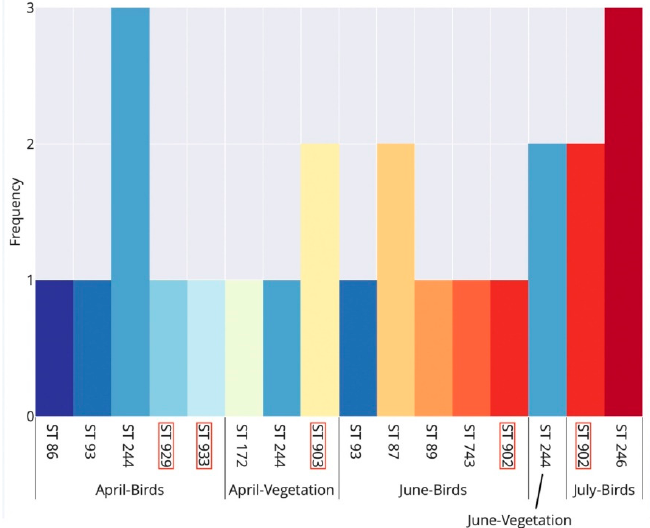
Figure 3. Seasonal occurrence of multi-locus sequence types (STs) of Borrelia garinii detected in bird-feeding and questing Ixodes ricinus ticks in Slovakia. Birds and vegetation denote bird-feeding and questing ticks, respectively. Each ST is denoted by a unique bar colour. ST labels with a red margin indicate novel STs detected for the first time in this study. Note that no ST was resolved for questing ticks in